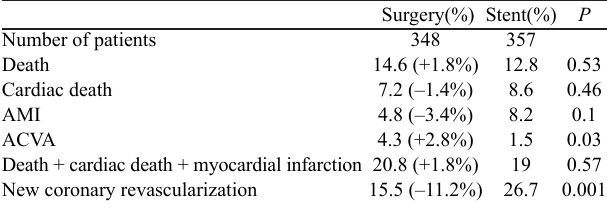
Table 5. 5-years results of SYNTAX trial on left trunk disease